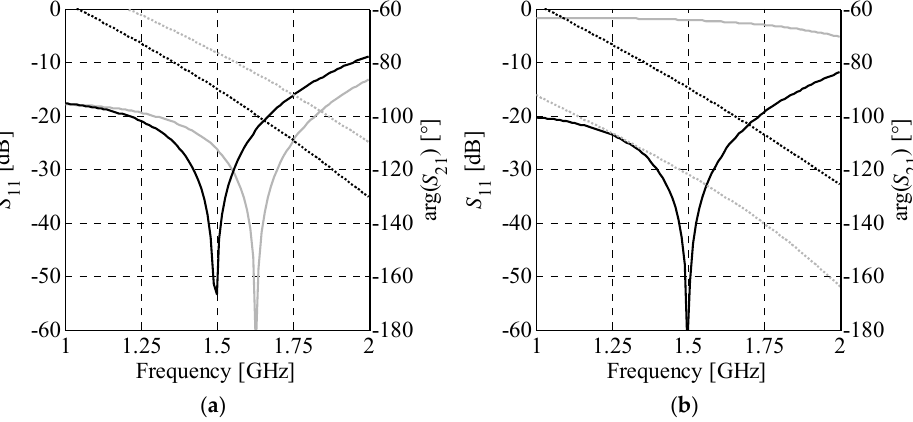
Figure 10. Low-fidelity model reflection (–) and phase (···) responses of individual cells at the randomly generated initial (gray) and optimized (black) designs: ( a ) cell C H (4) and ( b ) cell C V (3) .